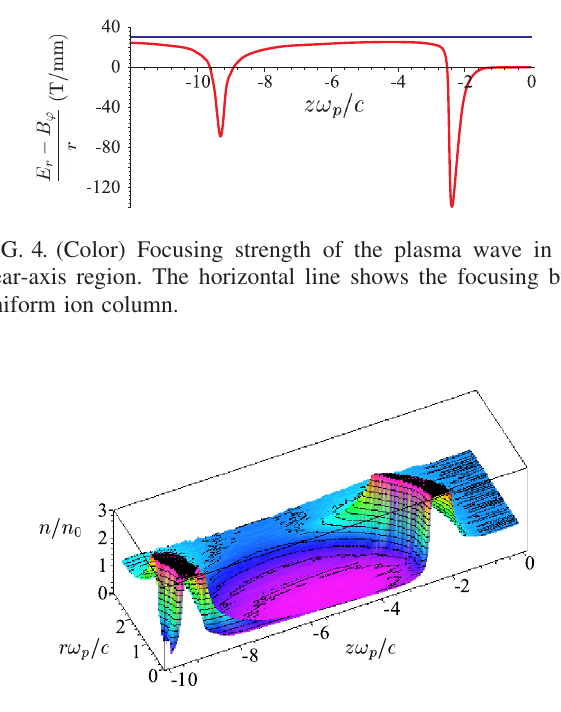
5. (Color) The density of plasma electrons in the unloaded wakefield ( L ¼ 90 m